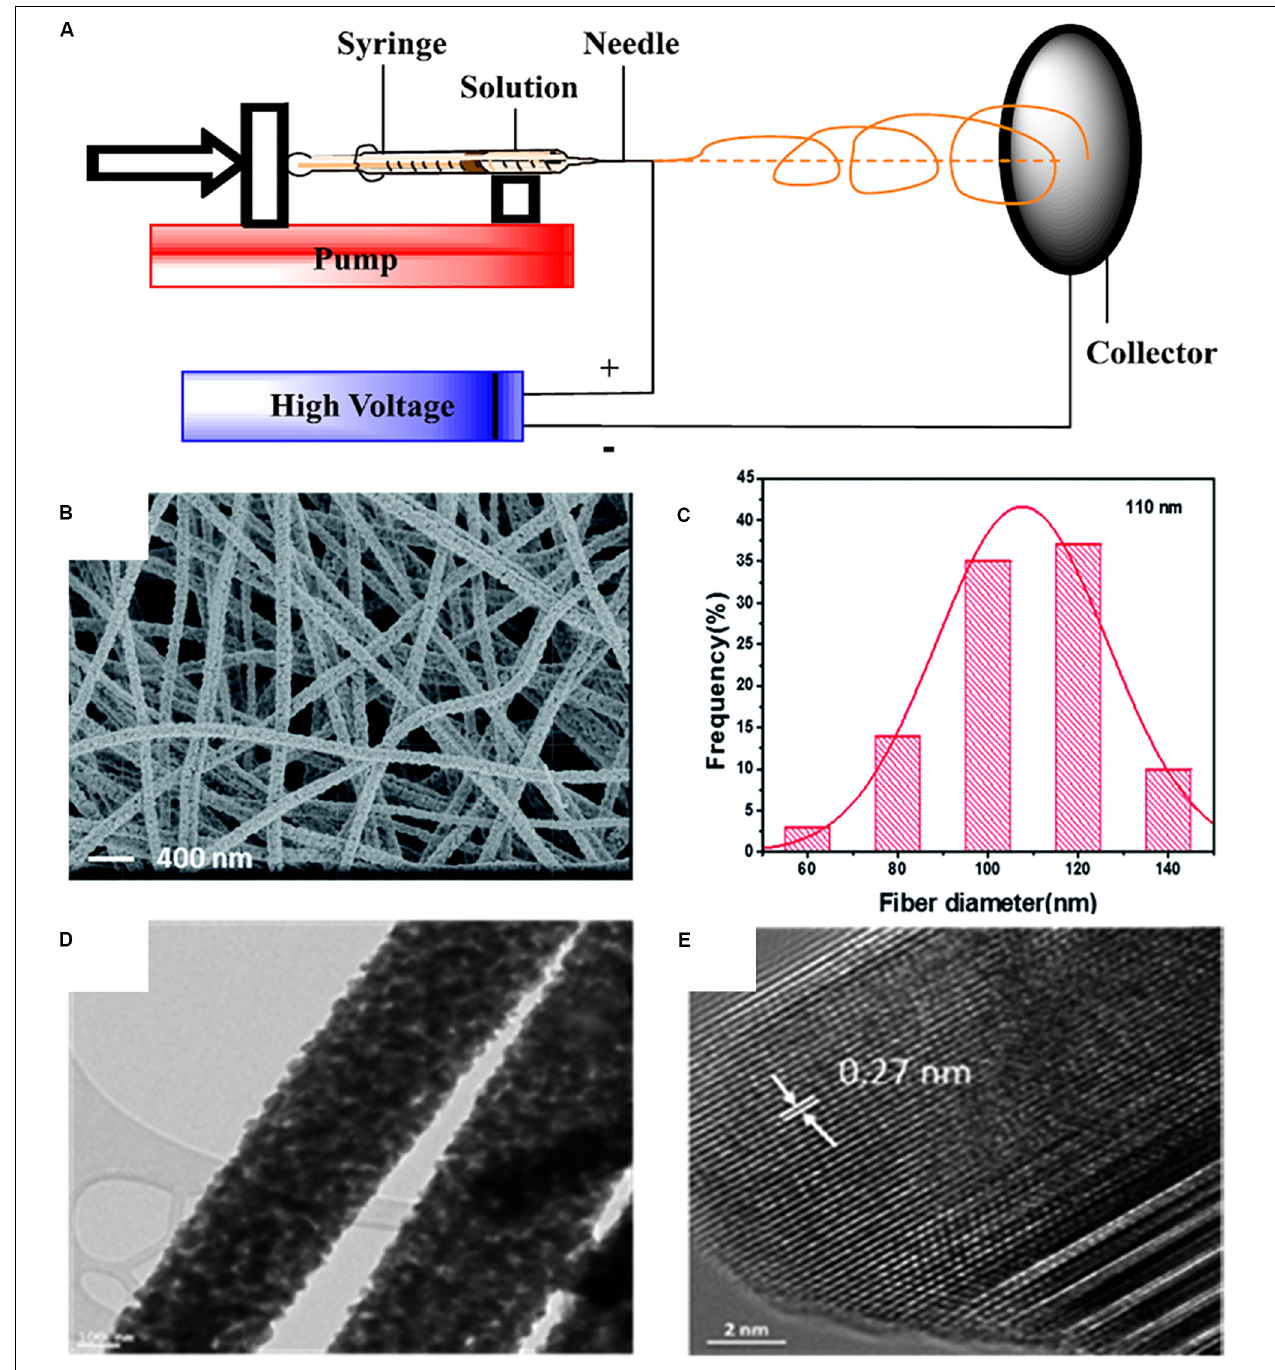
FIGURE 5 | (A) Schematic illustration of the setup of electrospinning. Reprinted with permission from reference Zhu et al. (2016c). Copyright 2016 Elsevier. (B) SEM images of the prepared LLTO nanofibers and (C) the corresponding diameter distribution. (D) Low- and (E) high-resolution TEM images of the LLTO nanofibers. Reprinted with permission from reference Zhu et al. (2018a). Copyright 2018 Royal Society of